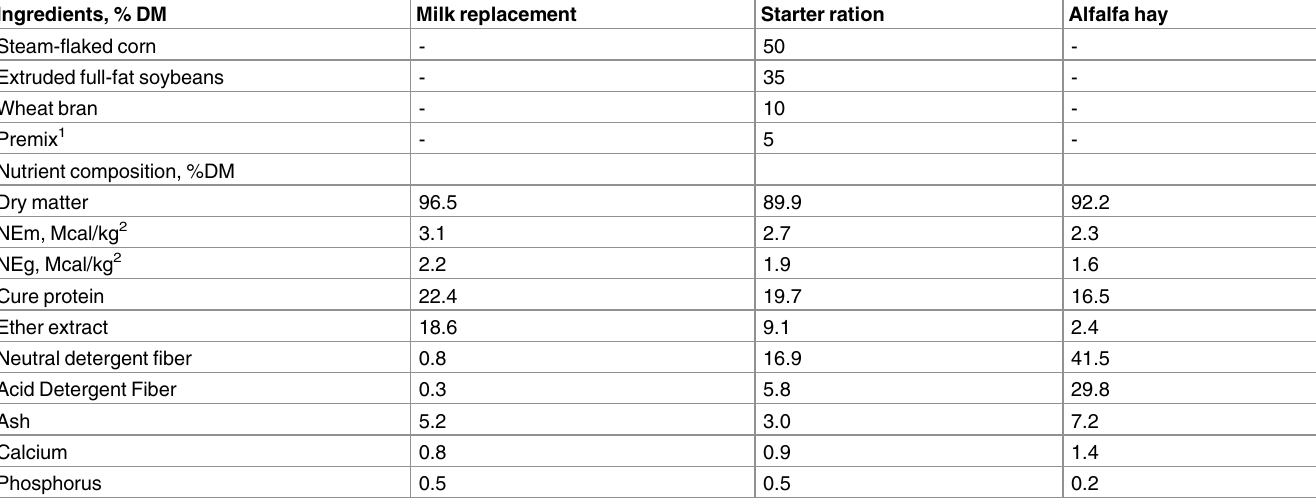
Table 1. The ingredients of starterand the nutrient compositions of milk replacement, starterration, and alfalfa hay. Ingredients, % DM Milk replacement Starter ration Alfalfa hay Steam-flaked corn - Extruded full-fat